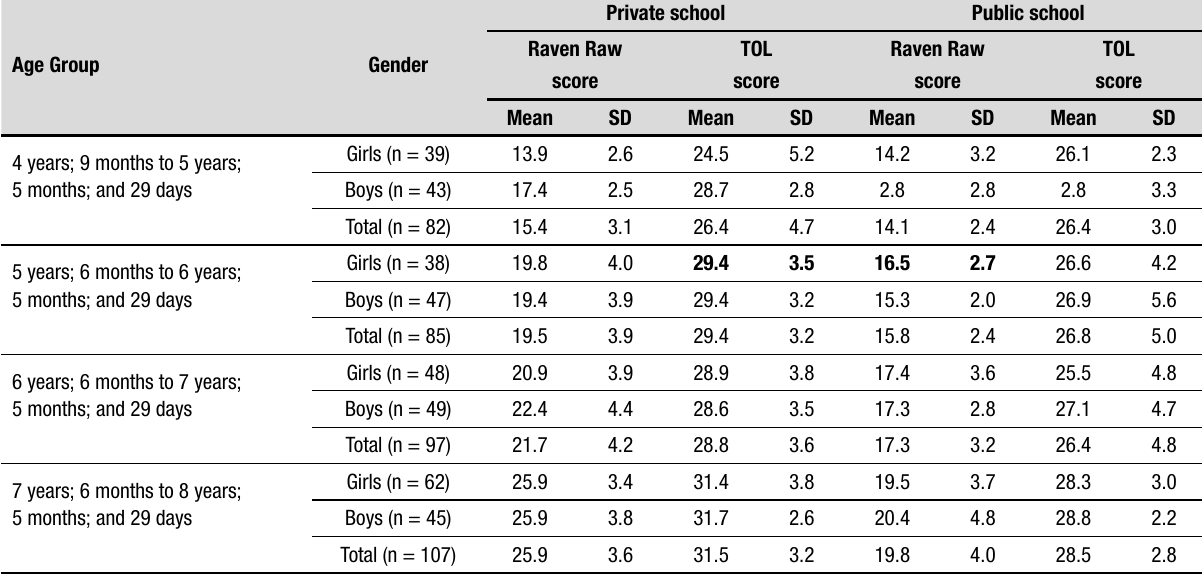
Table 2. Mean scores on the TOL and Raven tests as functions of age, gender, and type of school. Age Group Gender